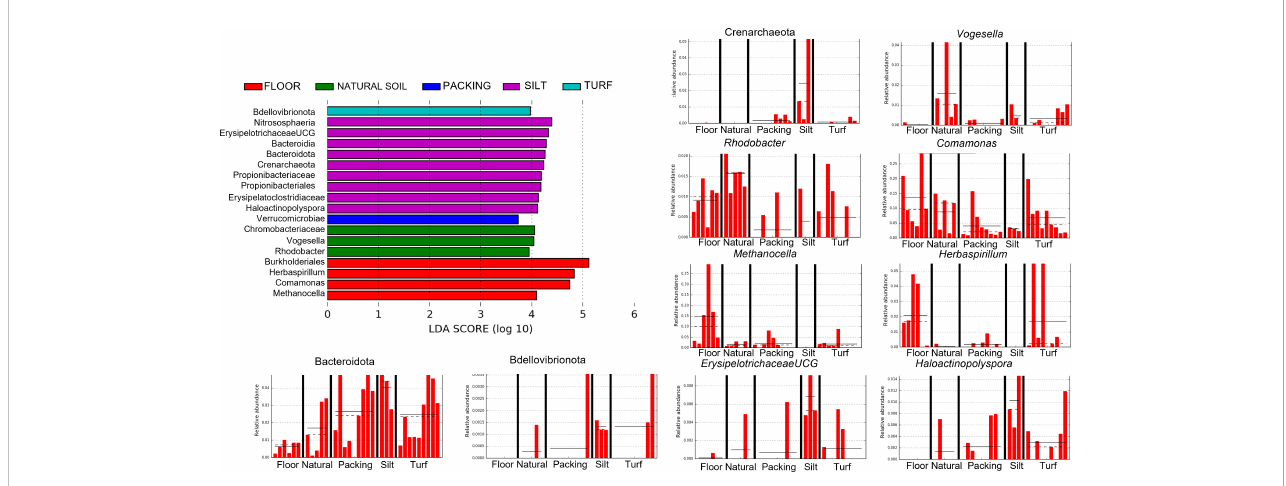
FIGURE 7 LEfSe analysis showing microbes indicative of occupational layers (top left). Relative abundance of signi fi cant Phyla and Genera shown in individual bar